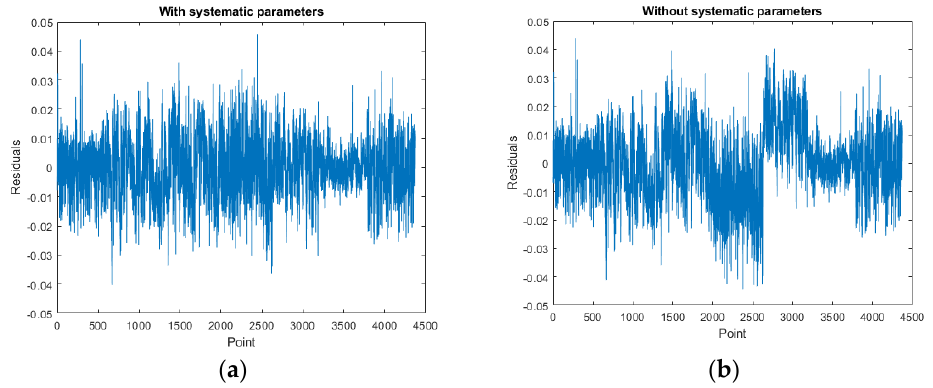
Figure 24. The residual scatter diagram of dataset DATA3. ( a ) with Aps; ( b ) without Aps. Table 10. Average residual and unit weight standard deviation for the three datasets using least- squares adjustment, with and without ranging APs.